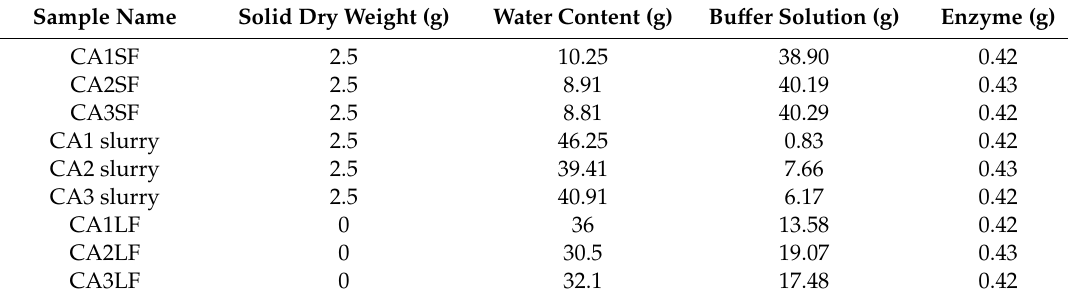
Table 2. Enzymatic hydrolysis conditions used to determine the EY values of cellulose and hemicellulose. Note: SF = solid fraction; LF = liquid